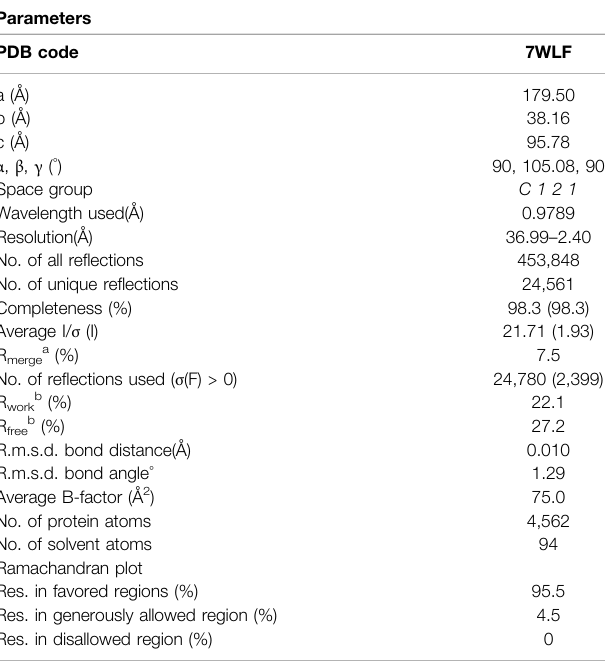
Frontiers in Chemistry |